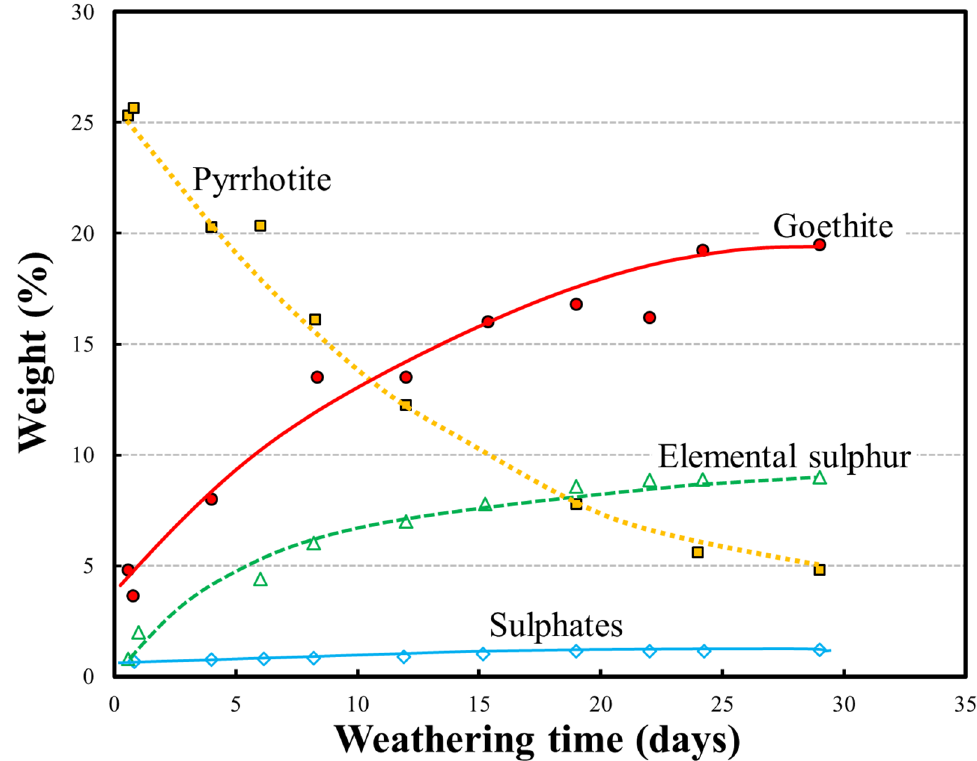
Figure 1. Effect of weathering in Stage A at 50 °C on reduction in pyrrhotite content and increase in Figure 1. E ff ect of weathering in Stage A at 50 ◦ C on reduction in pyrrhotite content and increase in oxidation products (adapted from Rosenblum and Spira [18]). oxidation products (adapted from Rosenblum and Spira